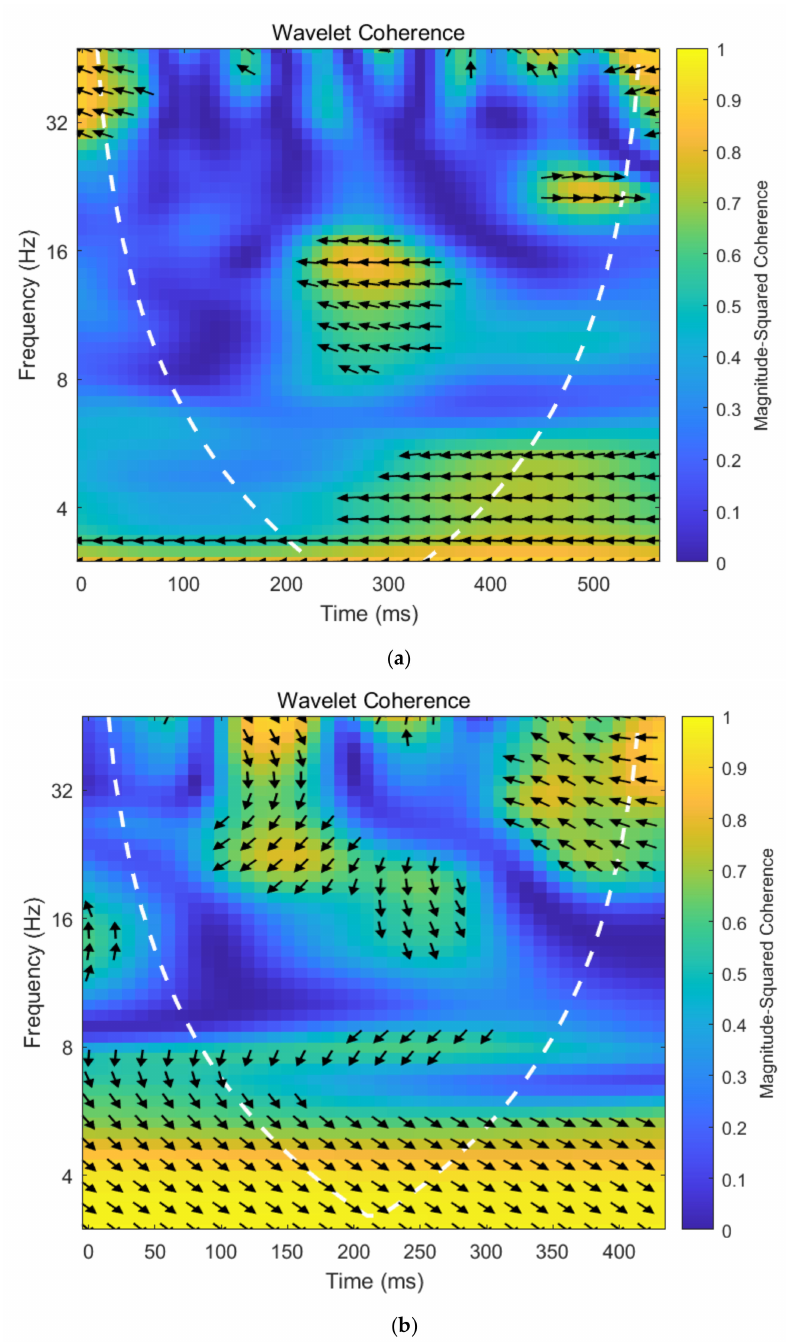
Figure 6. The wavelet coherency map between oil supply shocks and investor sentiment under different trends of crude oil price. ( a ) exhibits the wavelet coherency map of oil supply shocks and investor sentiment under rising trend in crude oil prices, while ( b ) presents the wavelet coherency map of oil supply shocks and investor sentiment under down trend in crude oil prices. The color of a region from blue to yellow implies the coherence correlation between oil supply shocks and investor sentiment become greater. The arrows show the correlation and lead lag relationship between oil supply shocks and investor